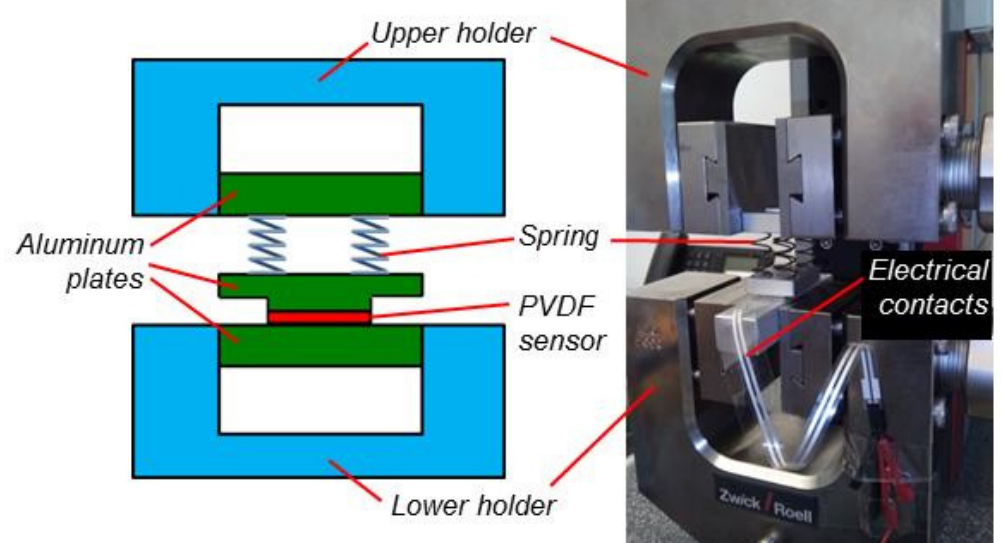
Figure 4. Tensile testing machine equipped with springs to measure the relationship between voltage and force in 3-direction. Left: Schematic cross-section not to scale; right: Photo.